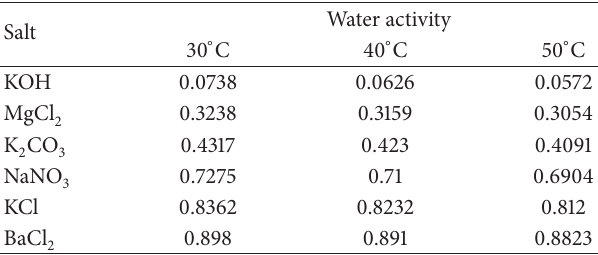
Table1:Selectedsaltsusedforpreparingsaturatedsaltsolutionsand their corresponding water